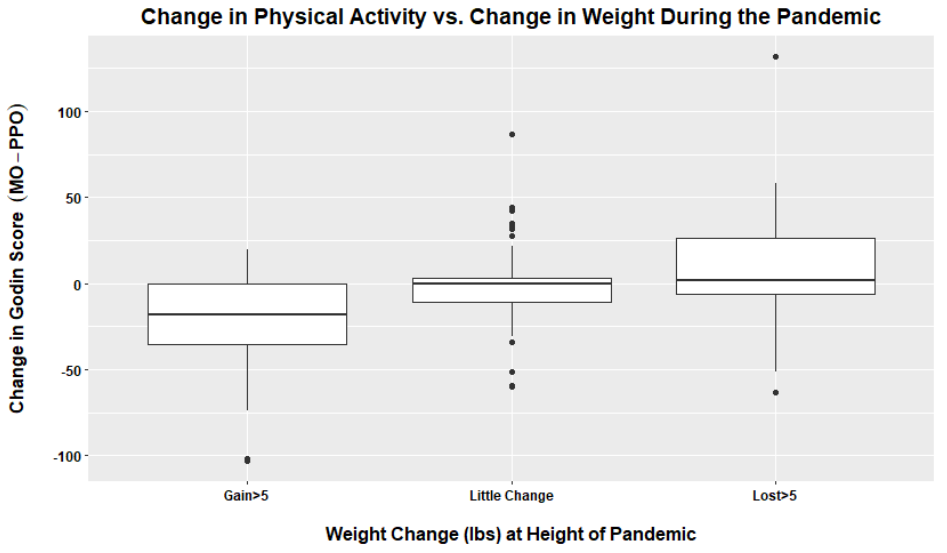
Figure 2. Change in physical activity vs. change in weight during pandemic based on Godin Scale scores (height of pandemic M0 vs. prior to pandemic PP0).